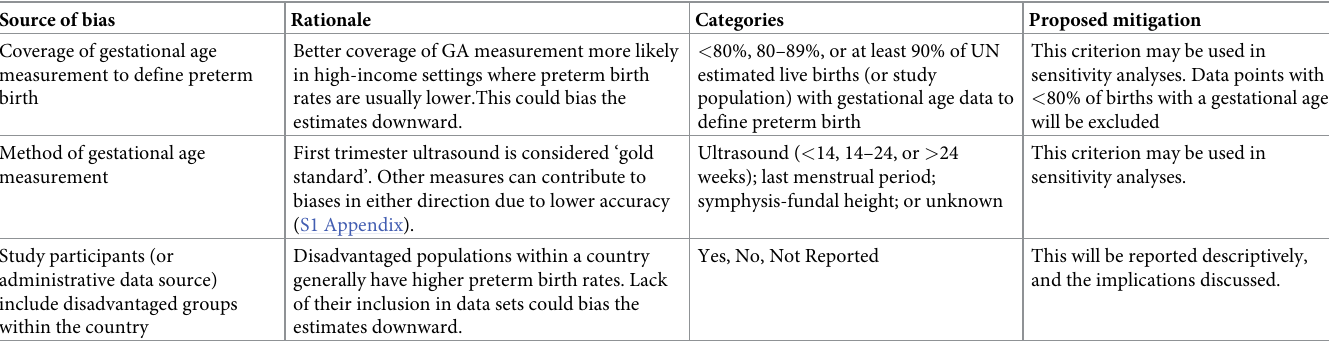
Table 1. Risk of bias